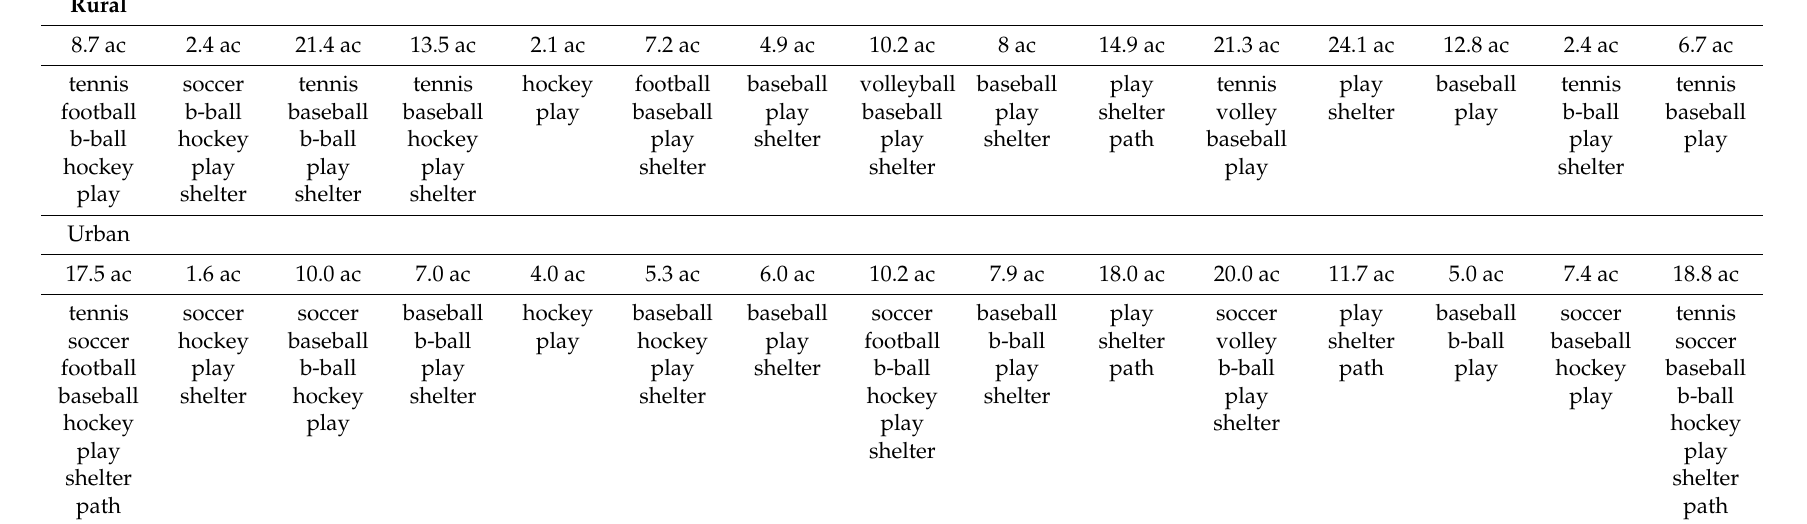
Table 1. Study parks’ area and